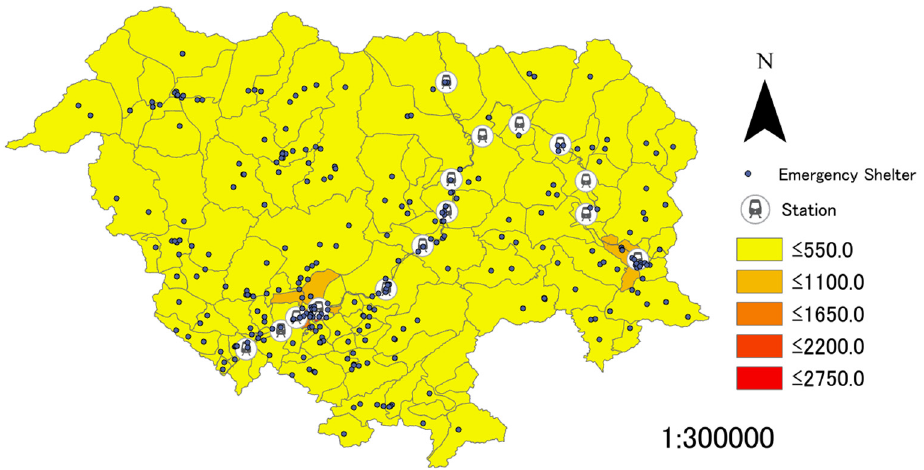
Figure 19. Result for Shobara City with the ratio of elderly population as a weighted coefficient.